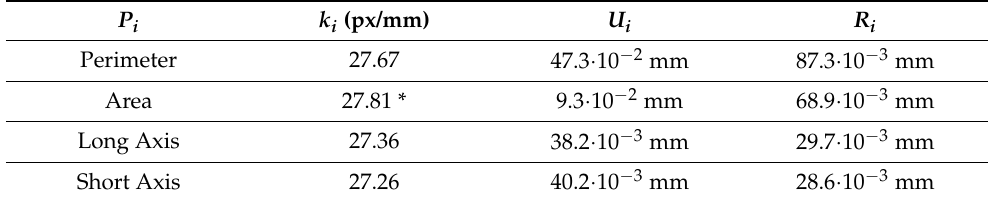
Table 1. Conversion coefficients, uncertainty bandwidth and resolution of the vision tool. Figure 7. Calibration diagrams for ( a ) perimeter, ( b ) area, ( c ) long and ( d ) short axes. The uncertainty bandwidth in the 3σ limit is also shown.